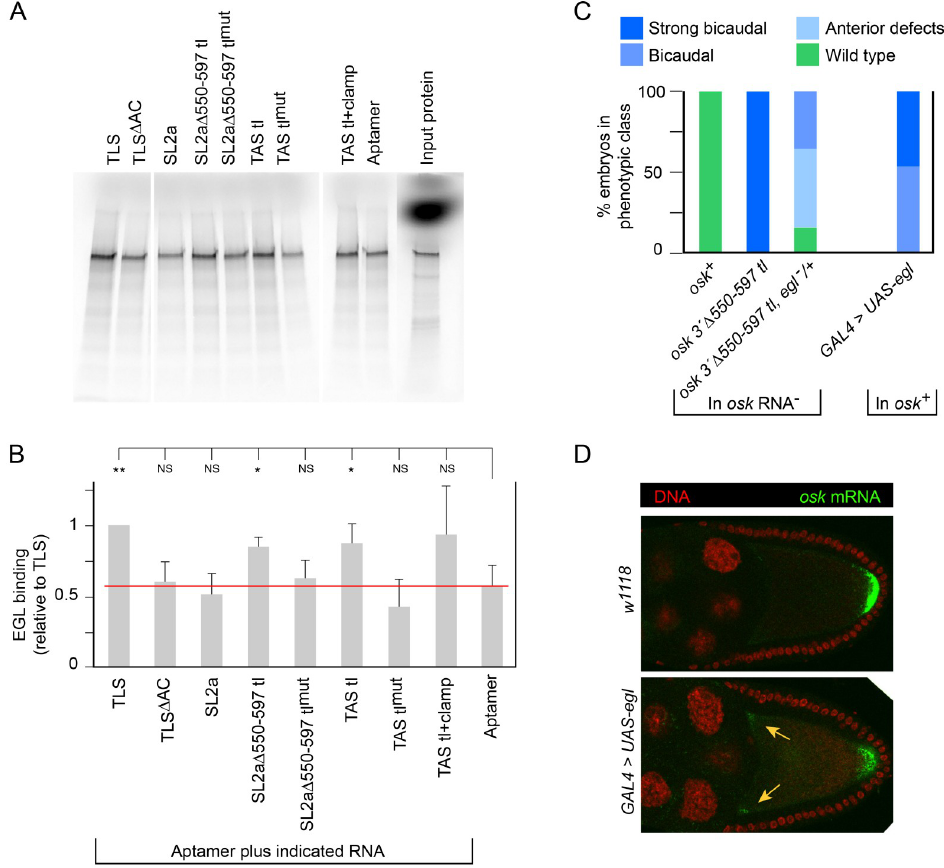
Fig 3. EGL binds the TAS in vitro and EGL level in vivo influences osk mRNA distribution and activity. (A) Representative binding assay. Radiolabeled EGL was synthesized in rabbit reticulocyte extracts for capture by RNAs tethered to streptavidin beads via the S1mx4 aptamer. Bound protein was visualized by SDS-PAGE and quantitated. The samples were from the same set of binding assays, analyzed on two separate gels. Input protein, not subjected to the binding assay, was 10% of that used in each binding assay (the diffuse spot of signal near the top of the ‘Input protein’ lane is the unincorporated 35 S-methionine). RNAs are based on those shown in Fig 1D, with inactivating mutations corresponding to those within the TAS in mutant Δ 550–597 tl 539–540 in Fig 1E. (B) Summary of three independent sets of binding assays. Results from each set of assays was standardized to the level of EGL binding to the TLS prior to analysis. Error bars show standard deviations. Statistical significance was evaluated by one-way ANOVA with F(8,18) = 4.44, P < 5 x 10 − 3 . Normality could not be rejected (Bonferroni corrected Shapiro-Wilk test), therefore Student’s t test was used for post hoc analysis. �� : P < 0.05, � : P < 0.1, NS: not significant. (C) Axial patterning of embryos from mothers with transgenes as indicated. The egl - /+ flies were heterozygous for egl 1 . GAL4 is the matalpha4-GAL-VP16 driver. Mutant phenotypes, from mislocalized osk activity, are defined as in Fig 1 with the addition of bicaudal (more than 3 duplicated abdominal segments). N values for all genotypes were greater than 300 except for GAL4 > UAS-egl , which was 222. (D) Distribution of osk mRNA in late stage 9 egg chambers. Sites of abnormal osk mRNA enrichment in the oocyte for this stage are indicated with arrows (orange). 30 late stage 9 egg chambers of each genotype were scored for the presence of anterior osk mRNA by the approach described in Materials and methods. For w 1118 , 0/30 had signal at the anterior. For EGL overexpression, 24/30 had signal at one or both of the two anterior/lateral junctions in the focal plane. Statistical significance was evaluated by the Wilcoxon rank sum test with P < 2 x 10 − 9 .